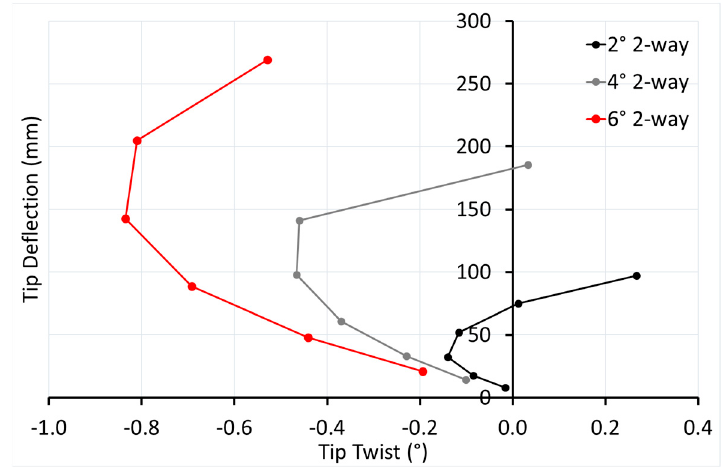
Figure 20. Tip deflection vs. tip twist (negative = wash-in = increased AoA).